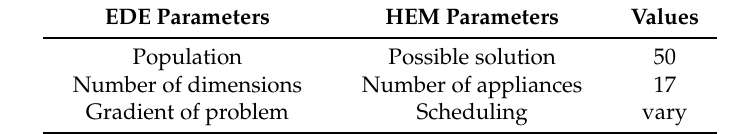
Table 5. Enhanced differential evolution (EDE) mapping on Home energy management